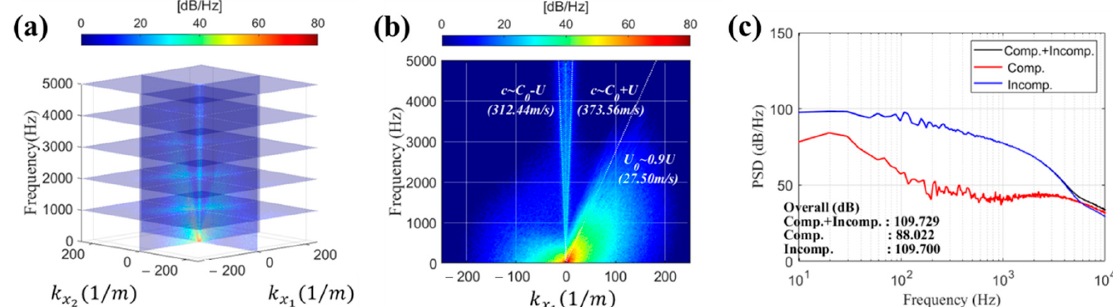
Figure 11. ( a ) Three-dimensional PSD diagram (left window), ( b ) two-dimensional diagram at = 0 , and ( c ) PSD levels of total, compressible, and incompressible pressure for left window of 𝑘 (cid:3051) (cid:3118) HSM (reference pressure 20 μPa ).